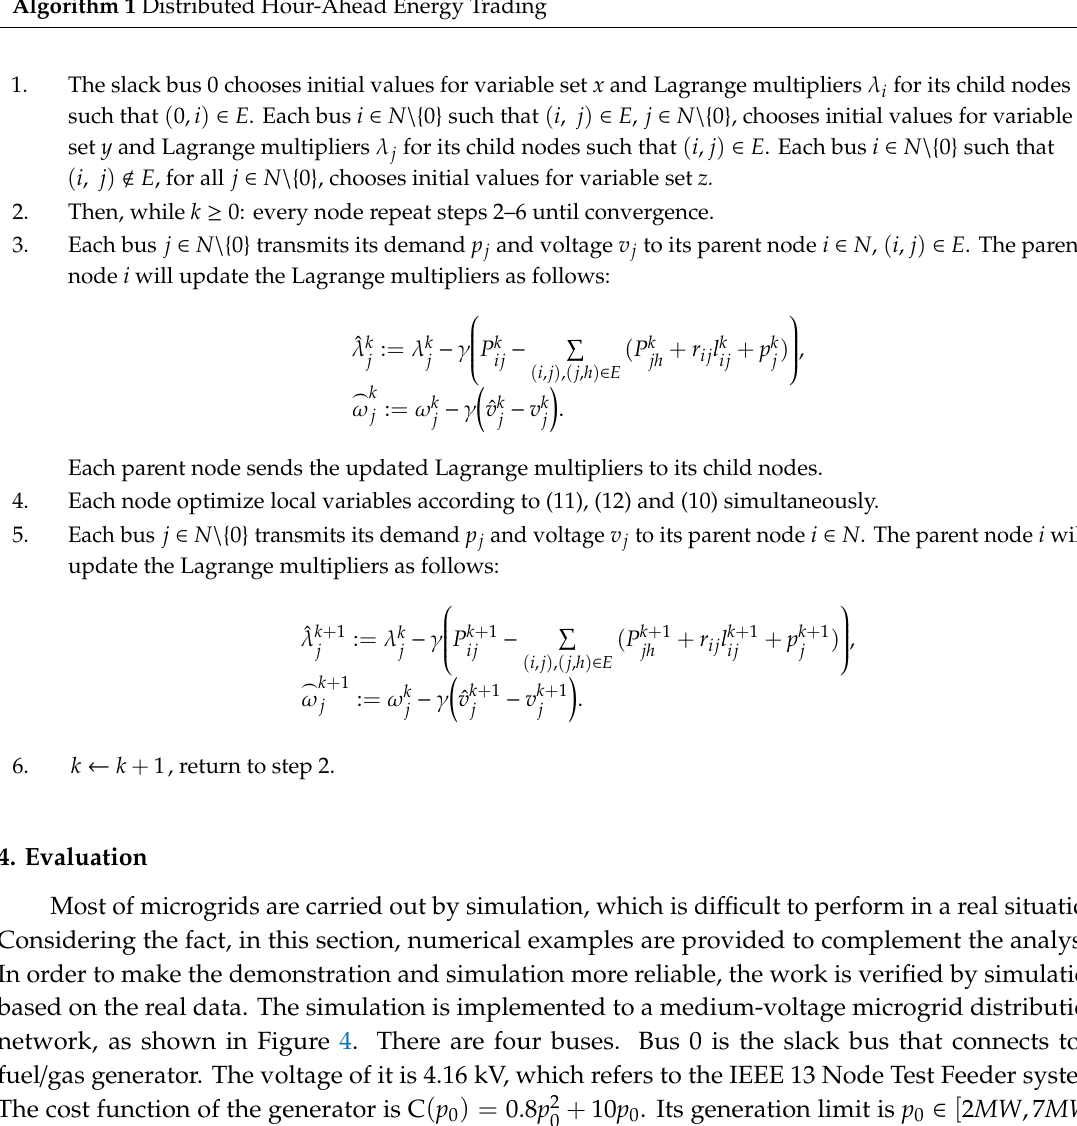
Algorithm 1 Distributed Hour-Ahead Energy Trading